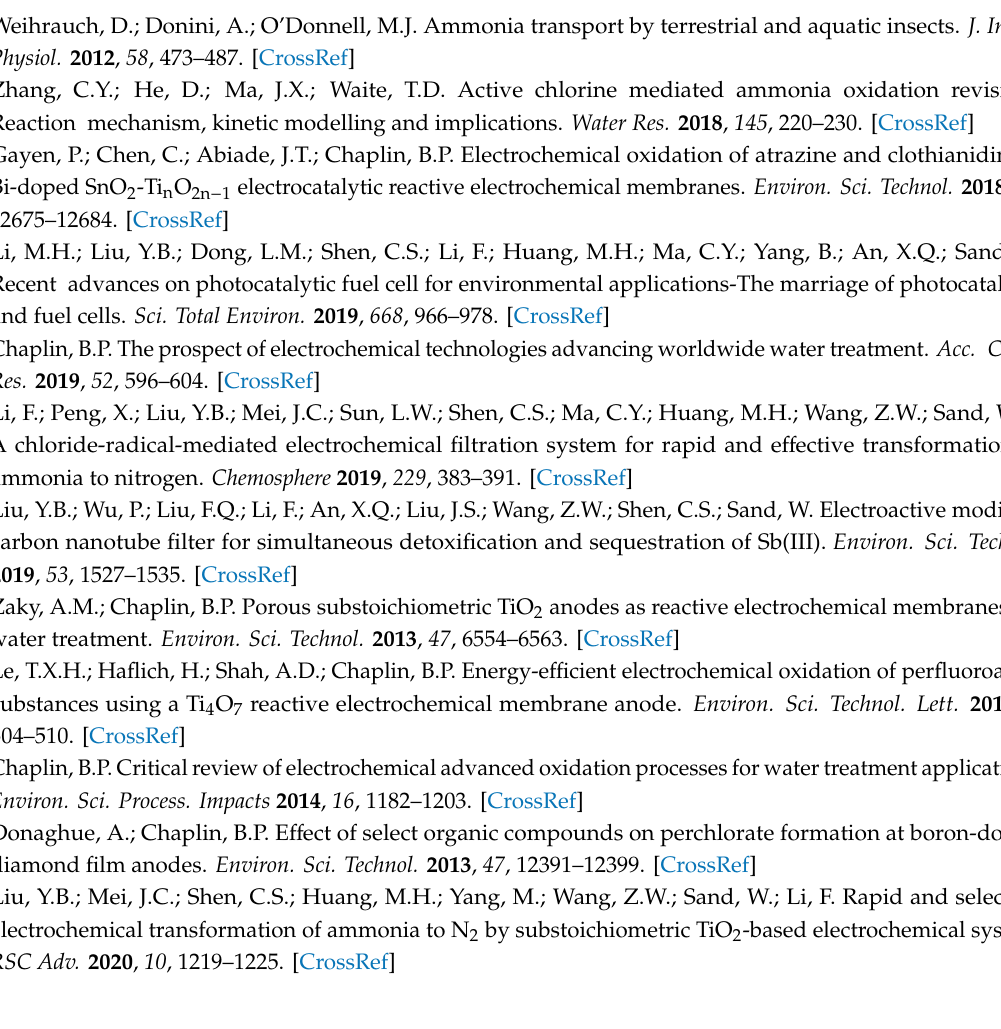
Figure S1: ( a ) FESEM characterization, ( b ) XRD pattern, and ( c ) XPS survey pattern of the Ti 4 O 7 anode. XPS narrow scan of ( d ) Ti 2p on Ti 4 O 7 electrode; Figure S2. XPS spectra for the narrow scan of ( a ) C 1s, and ( b ) O 1s on Ti 4 O 7 electrode; Figure S3: Digital pictures of ( a ) Pd-Cu / NF electrode, ( b ) Pd / NF electrode, ( c ) Cu / NF electrode, and ( d ) pure Ni foam electrode; Figure S4: FESEM images ( a , b ) of the Pd / Cu-Ni foam electrode. XPS spectra for the narrow scan of ( c ) Pd and ( d ) Cu of a fresh Pd-Cu / NF cathode; Figure S5: Comparison of ammonia conversion kinetics in batch, single-pass, and flow-through systems; Figure S6. The e ff ect of flow rate on ammonia conversion. Reaction conditions: anode potential of 2.8 V vs. Ag / AgCl, [Cl − ] concentration of 0.14 M, and pH of 9; Figure